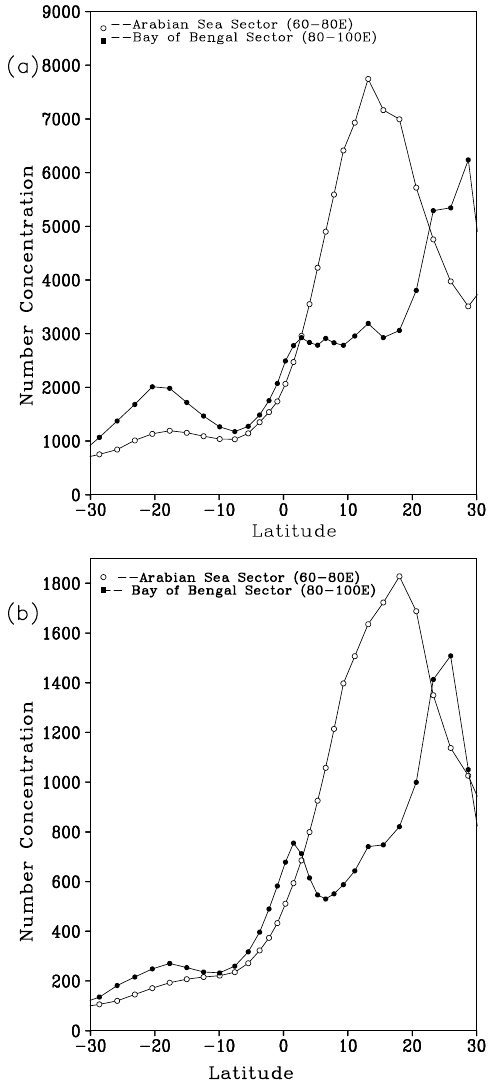
Fig. 7. Latitudinal variation of sulphate number concentration (par- ticle cm − 3 ) in the (a) Aitken and (b) accumulation modes over the Bay of Bengal and Arabian Sea